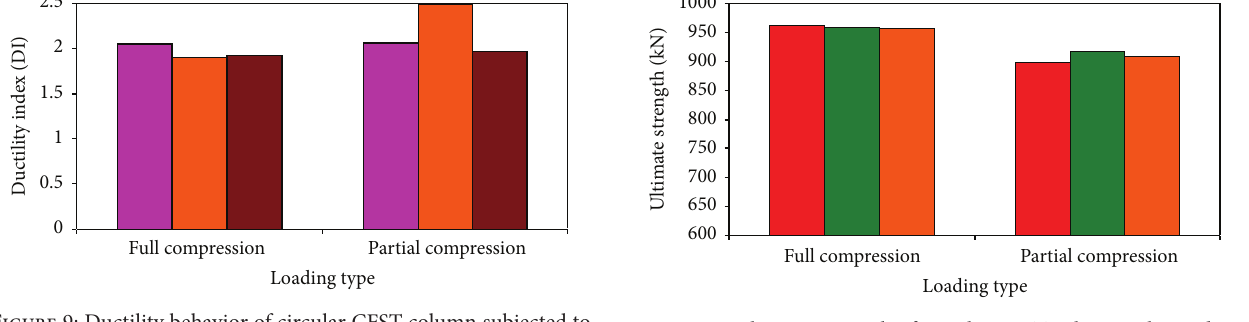
Figure 11: Ultimate strength of circular CFST column subjected to full and partial compression—comparison.